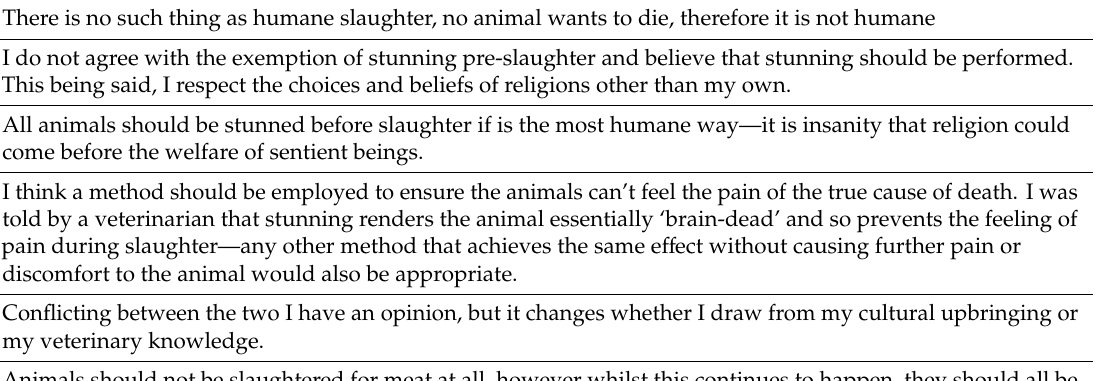
Table 2. Comments by respondents who choose the option ‘other’ to the question regarding their opinion on the use of pre-slaughter stunning for meat animals.